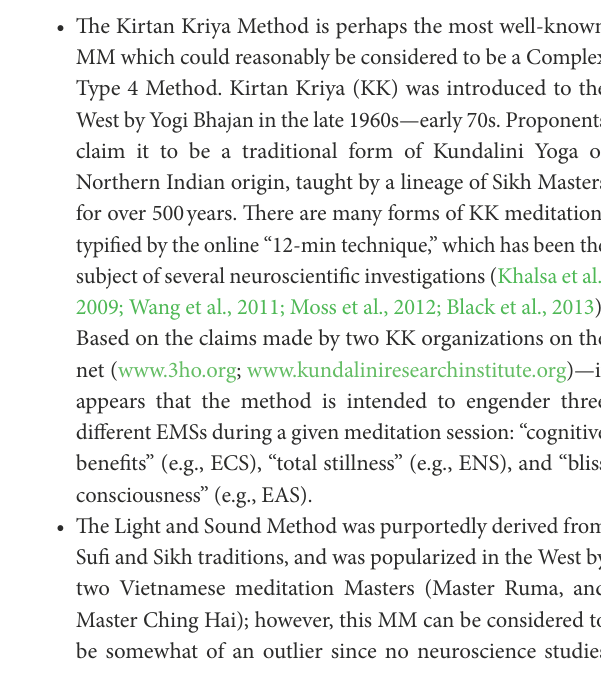
TABLE 1 The classification of several simple meditation methods into the three main domains. CDM